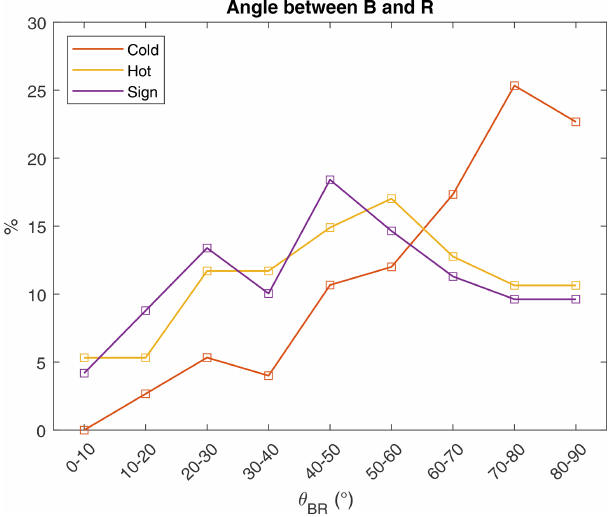
Figure 14. The angle between the radial direction and magnetic field direction binned per category in 10 ◦ -wide bins as a percentage of the total number of structures per